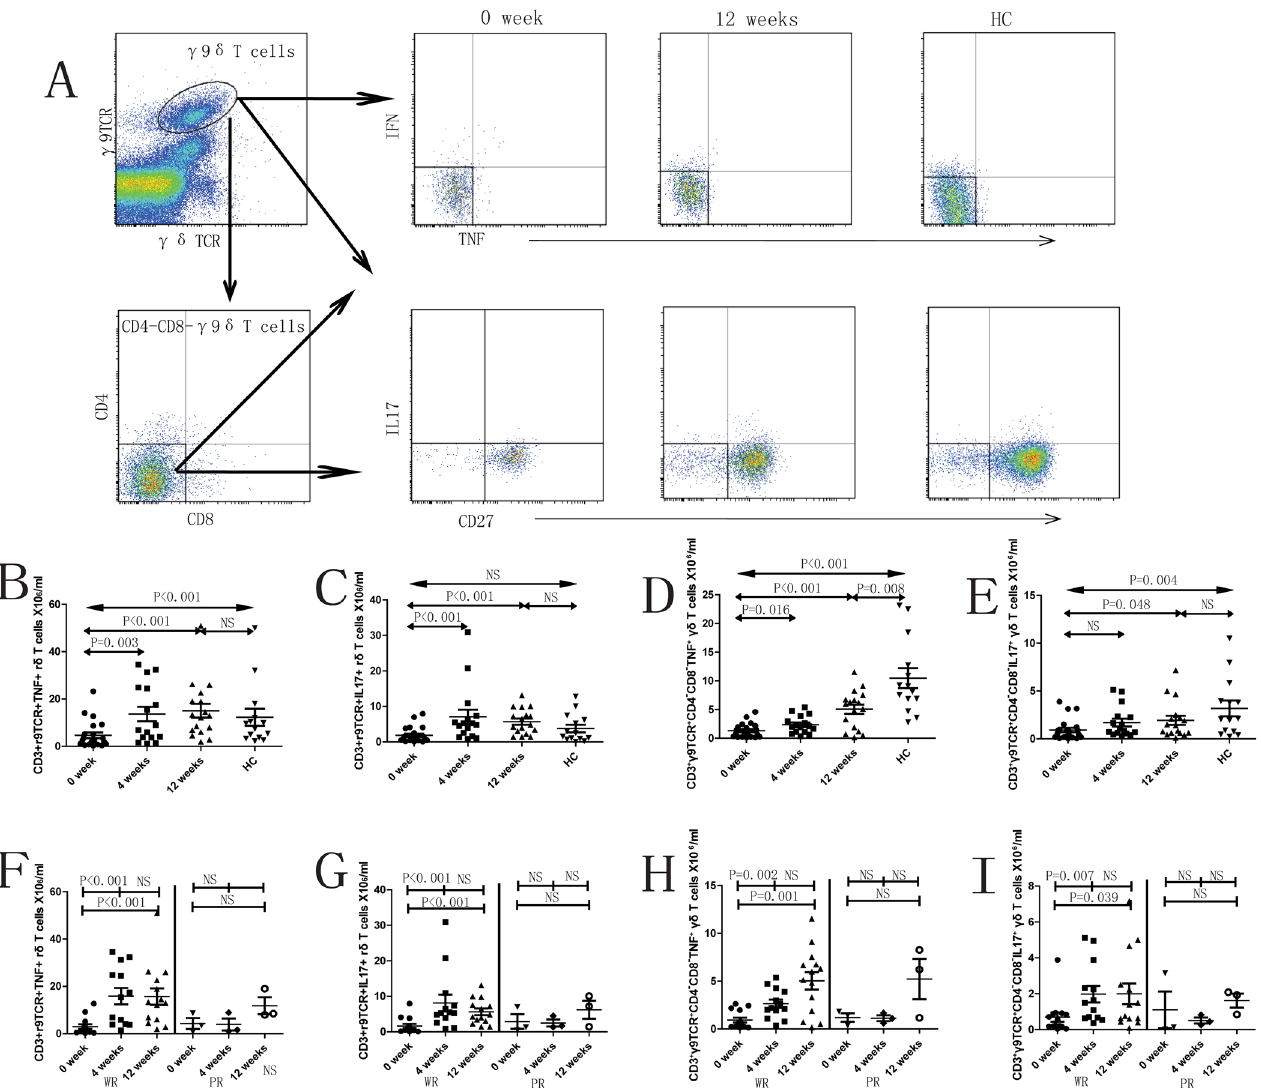
Fig 3. Characterization of different subsets of CD3 + γδ TCR + γ 9TCR + cells in SLE patients. A. The panels in this section show the gating strategy employed for the analysis of γδ T cells and subsets. Peripheral venous blood derived leukocytes were stained with different fluorescent antibodies and after lysis of red blood cells, the remaining cells were gated on living lymphocytes and further gated on CD3 + γδ TCR + γ 9TCR + cells and CD3 + γδ TCR + γ 9TCR + CD4 - CD8 - cells, and then further gated on IFN- γ + , TNF- α + , IL17 + and CD27 + cells, respectively. The frequency of different subsets of γ 9 δ T cells were analyzed by flow cytometry. B — I. Flow cytometry results represented as the scatter dot plots of γδ T cells and subsets in healthy controls (HC) or in SLE patients before and after therapy (treatment time is indicated). SLE patients are further grouped as responders (R) and non-responders (NR) based on response to